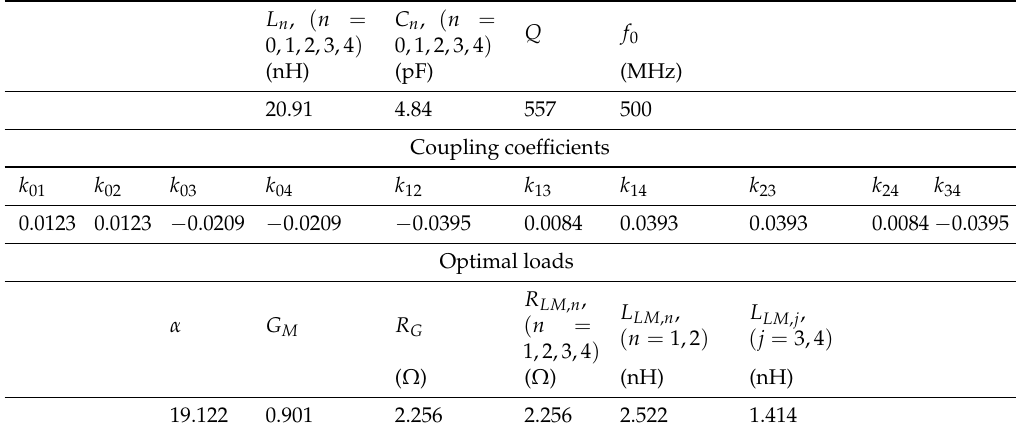
Table 3. Parameters of the equivalent circuit and optimal loads of the WPT link illustrated in Figure 5c (Case 3).